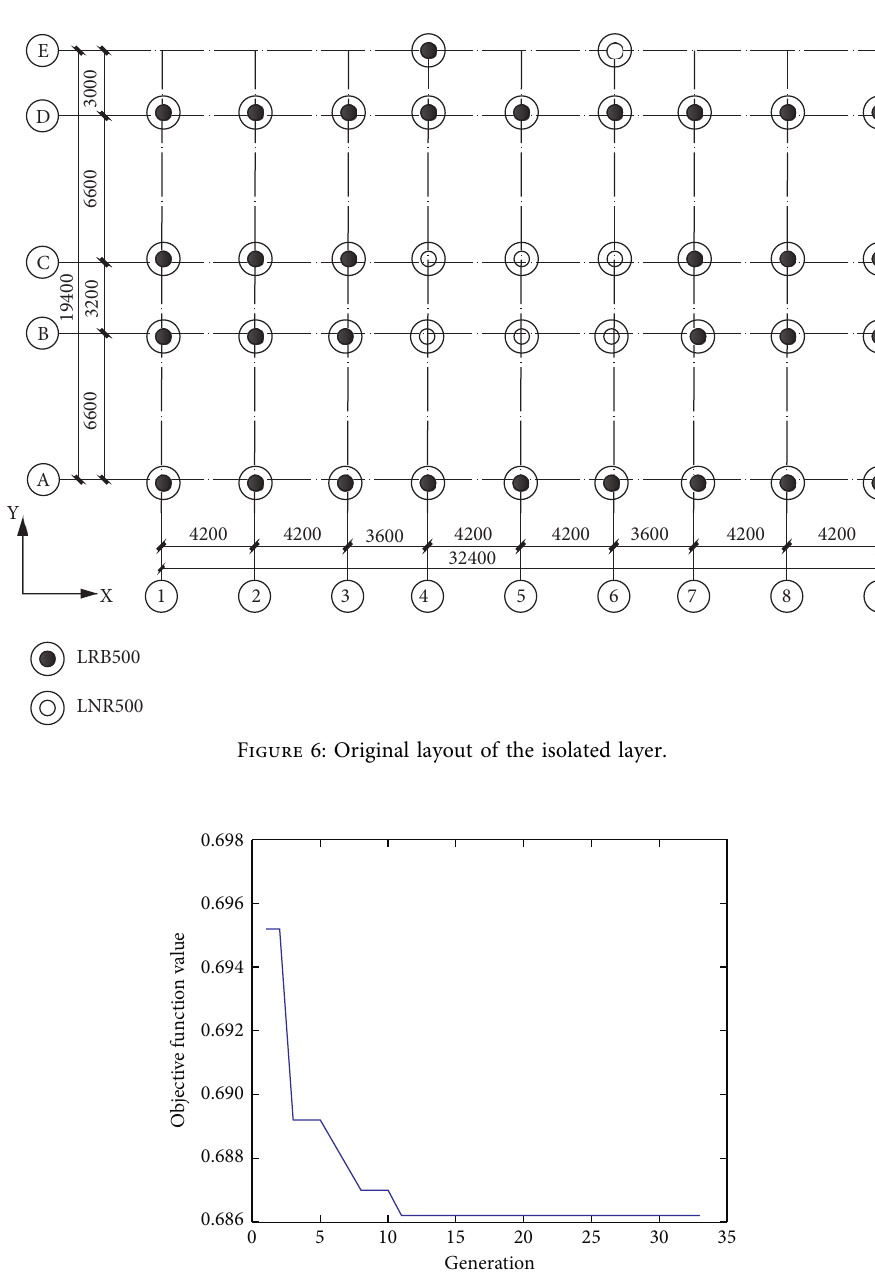
Figure 7: Evolution process of